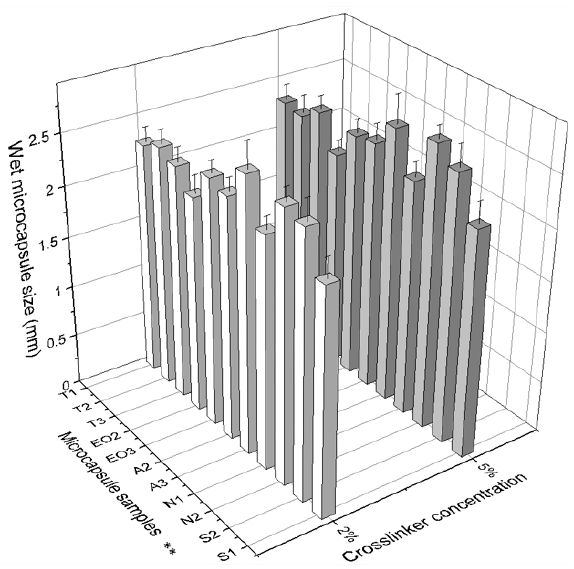
Figure 6. The effect of crosslinker concentration on the size of dry microcapsules. ** The code is given in Table 1, n = 30.